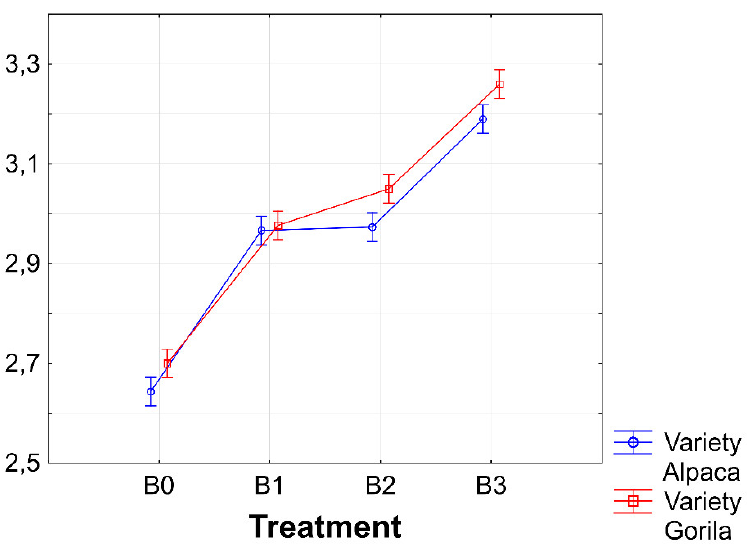
Figure 6. Interactions between biostimulants and varieties for leaf area index (LAI). B0—control;